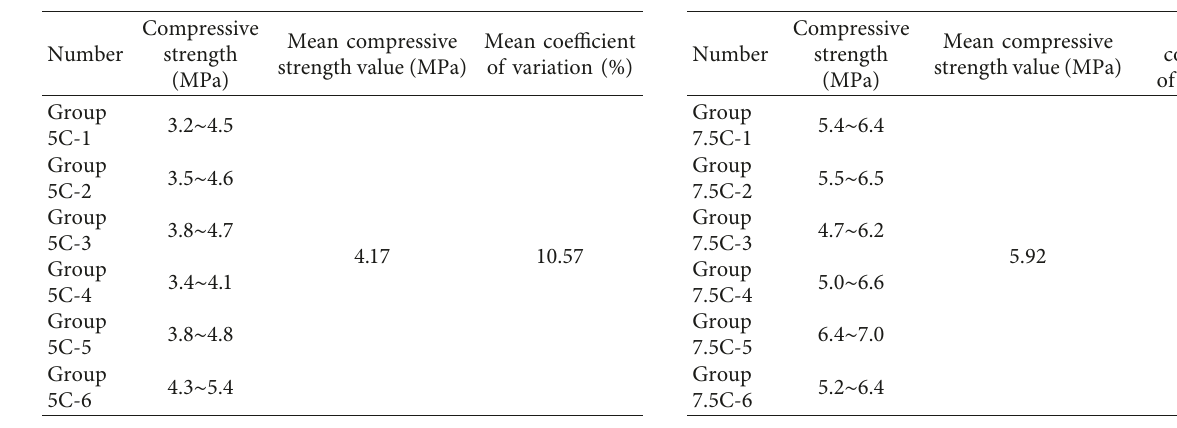
Figure 4: Testing HCCSEB masonry prisms under (a) compression and (b) shearing. Table 3: Compression test results for HCCSEBs with strength Table 4: Compression tests results for HCCSEBs with strength grade grade MU5.